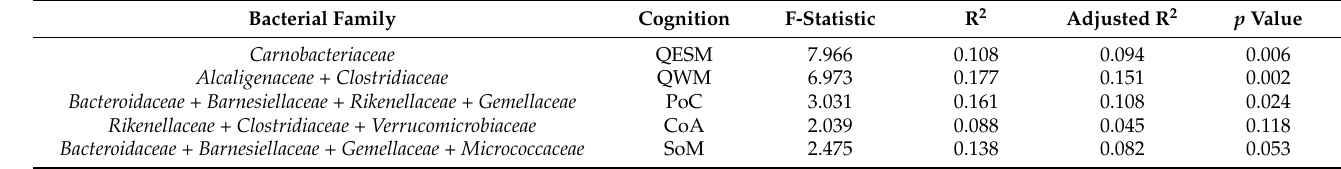
Table 5. Multiple linear regression showing the combined contribution of families with cognition.